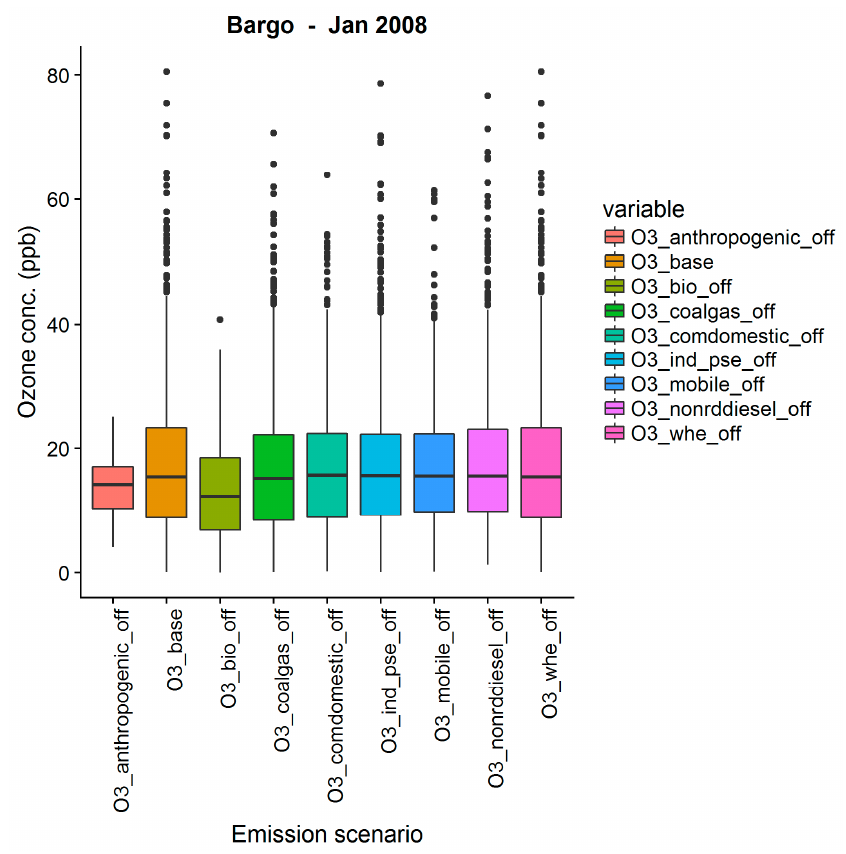
Figure A4. Box plot for 1-hour ozone concentration (ppb) in January 2008 under different emission scenarios at Bargo.